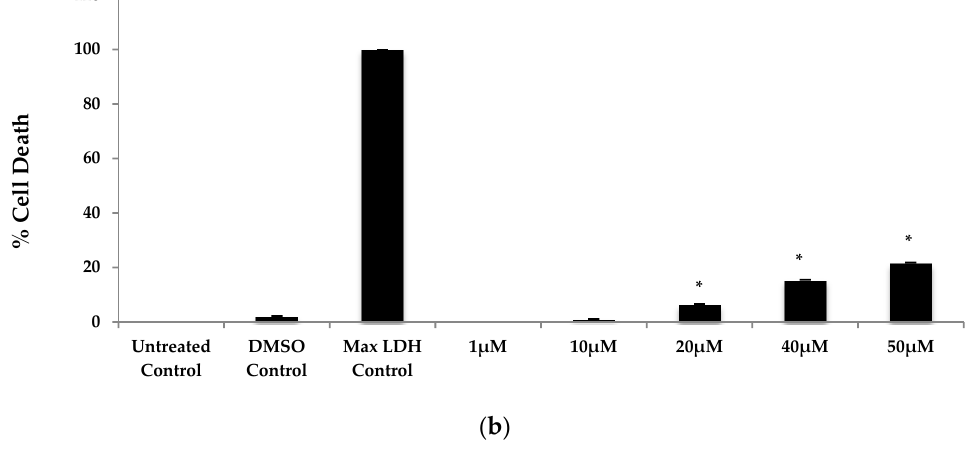
Figure 7. Cell proliferation and cell death analysis of BEAS-2B cells treated with alternariol (AOH). ( a ) A dose-dependent analysis of cell proliferation of BEAS-2B cells after treatment with AOH was performed by MTT assay. Cells were seeded at a density of 500,000 cells/well for 24 h; ( b ) A dose curve of lactate dehydrogenase (LDH) assay to measure the amount of LDH released by dead cells upon treatment with AOH for 24 h at a cell density of 20,000 cells/well. An * indicates p < 0.05 according to Student’s t -test for AOH treatments compared to dimethyl sulfoxide (DMSO)-treated controls.